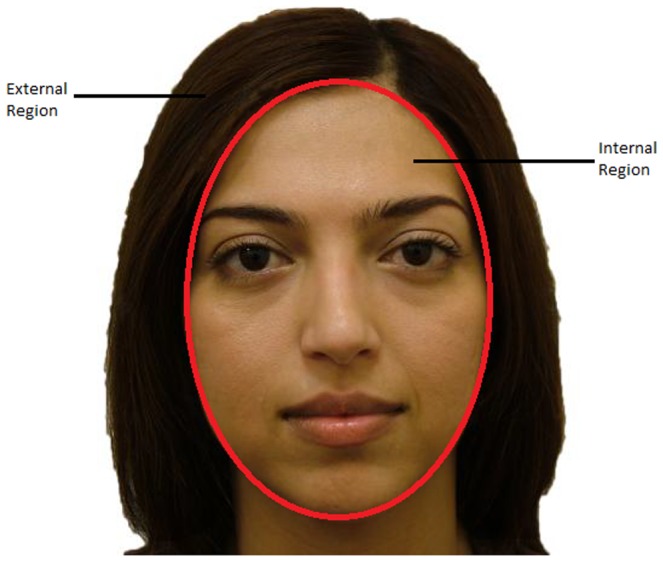
Illustrating the internal and external regions.